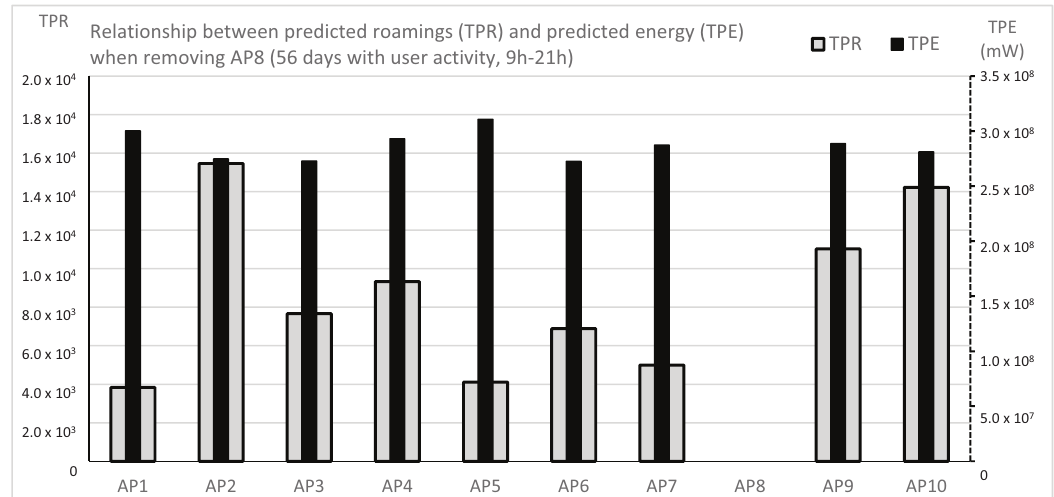
Figure 6. Energy prediction ( TPE ) in the simulated network, obtained from the roamings predicted ( TPR ) considering the same point coefficients C that define the relationship between roamings and energy for the full